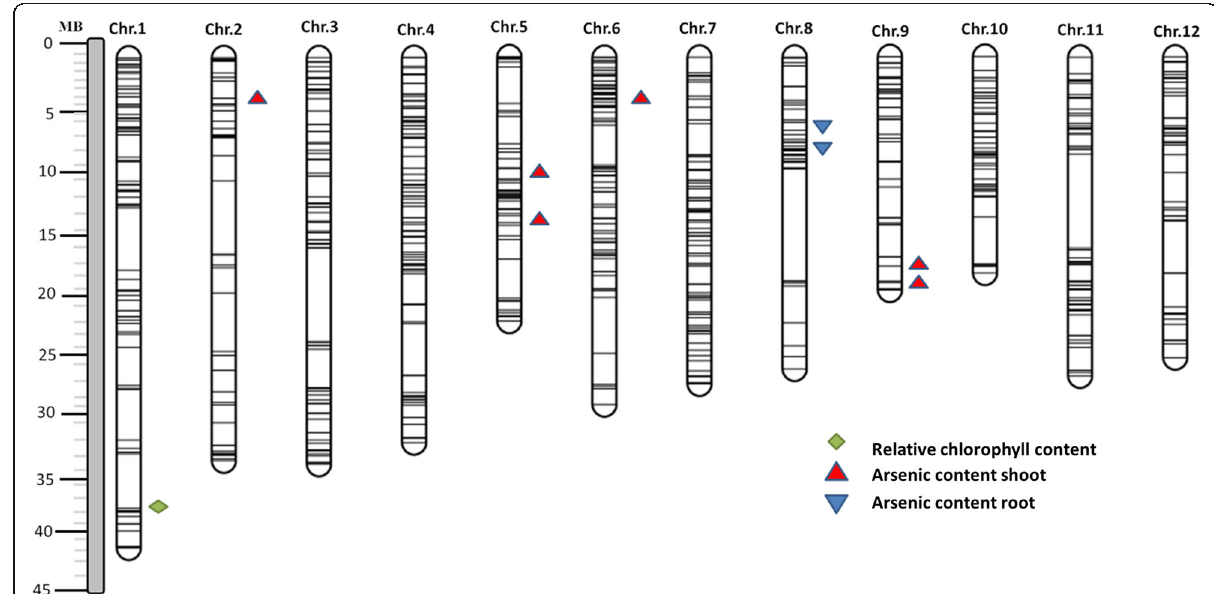
Fig. 4 Chromosomal distribution of polymorphic single nucleotide polymorphisms (SNPs) and quantitative trait loci (QTLs) detected in this study. QTLs were located on the chromosome based on the physical position of the SNP